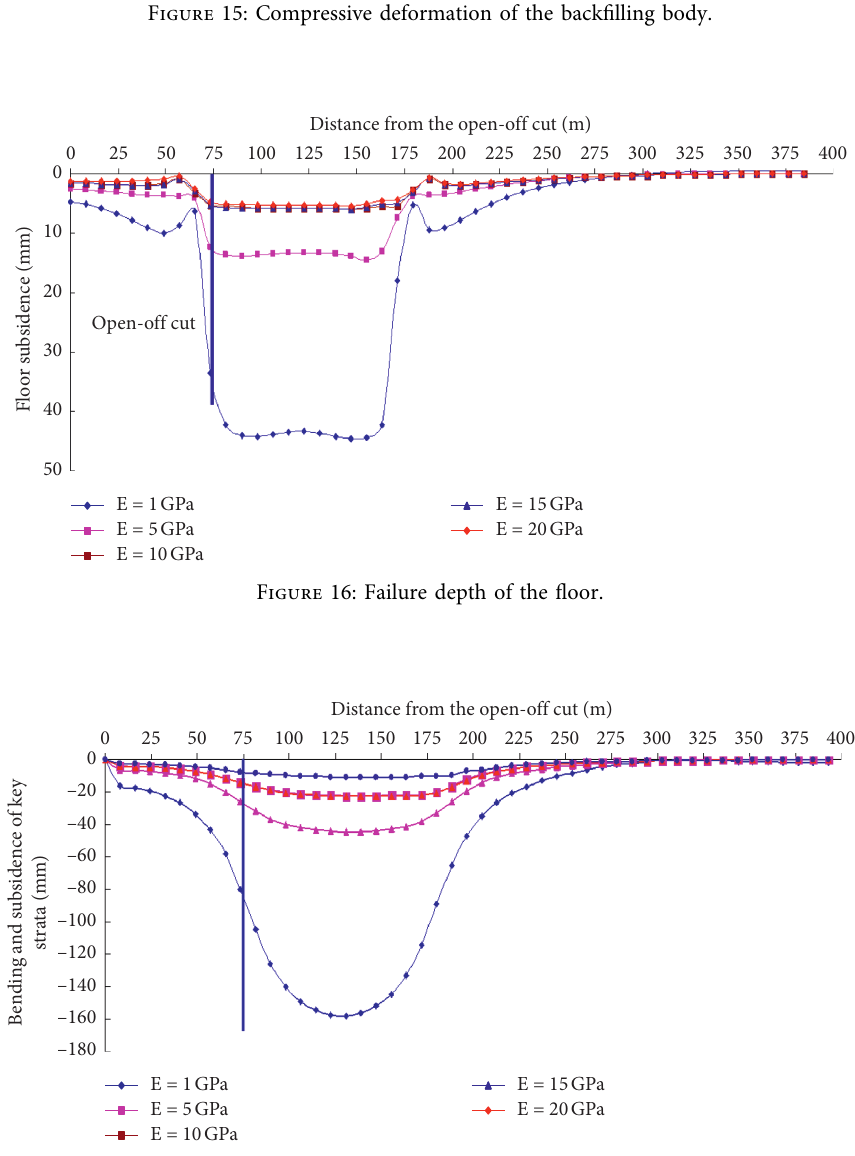
Figure 17: Bending and subsidence of the main roof.